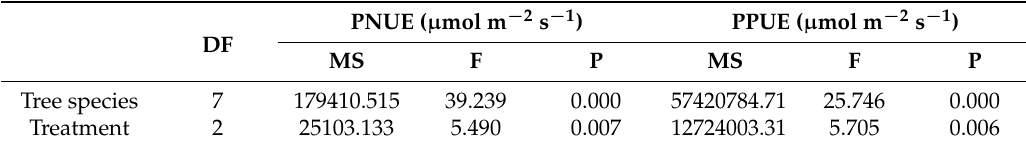
Table A2. Variance analysis of leaf PNUE and PPUE for eight Quercus species under wind load.